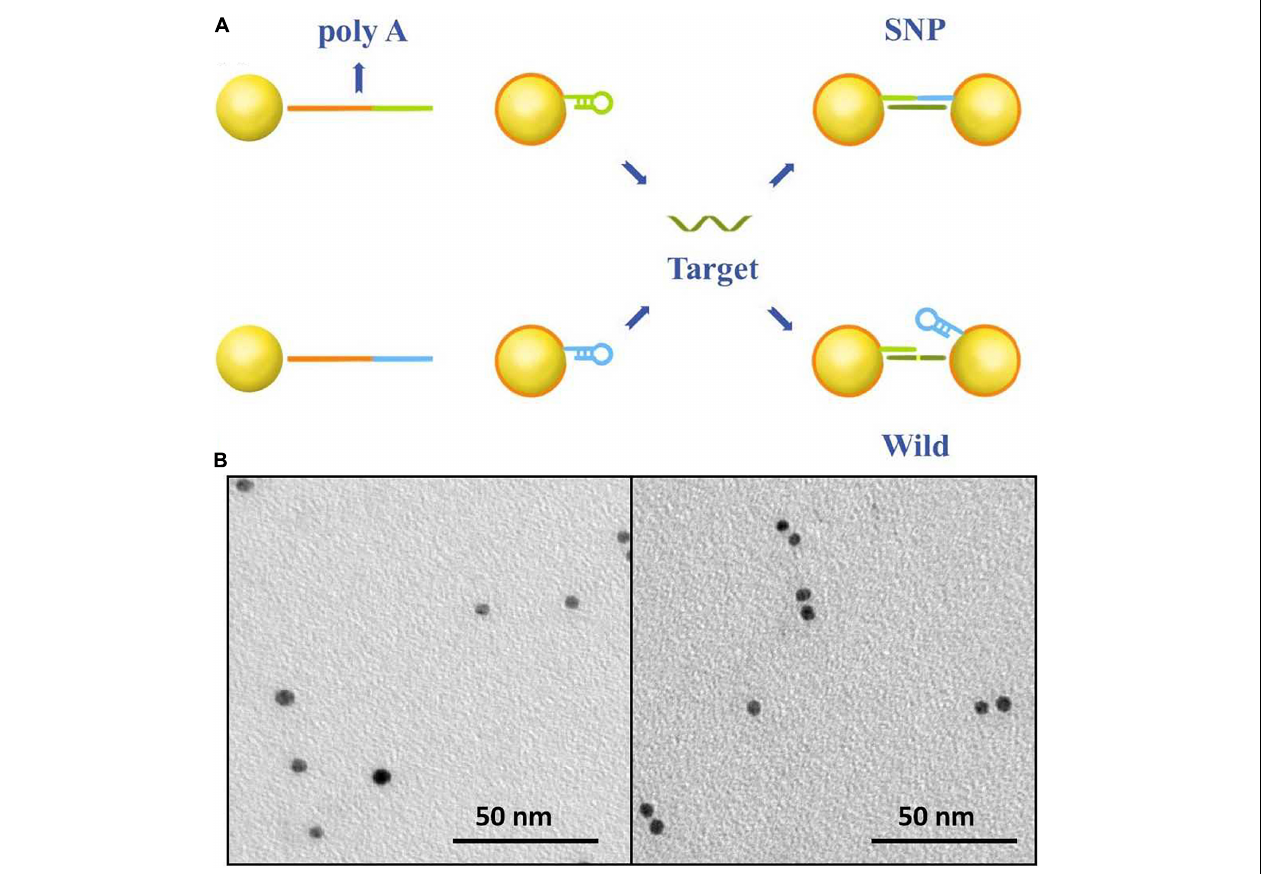
FIGURE 1 | (A) The work principle of the SNP detection system. The Au nanoparticles firstly were labeled by blocking DNA strands with the poly-adenine (polyA) block (red) and the recognition (blue and green). One block of polyA oligonucleotide could strongly absorb on the surface of gold nanoparticles; the other was designed to perfectly complementarily hybridize with SNP targets and mismatch to the wild-type targets. (B) SEM images of DNA-probed Au nanoparticles with wild targets in the form of monomer and SNP targets in the form of